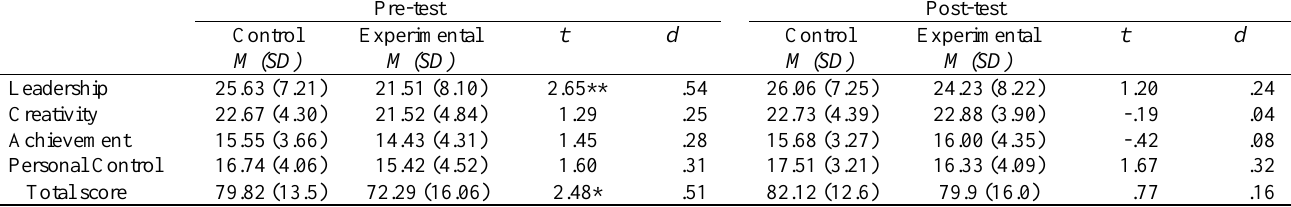
Table 3: ATE test factors: Control group vs. Experimental group on pre- and post-test